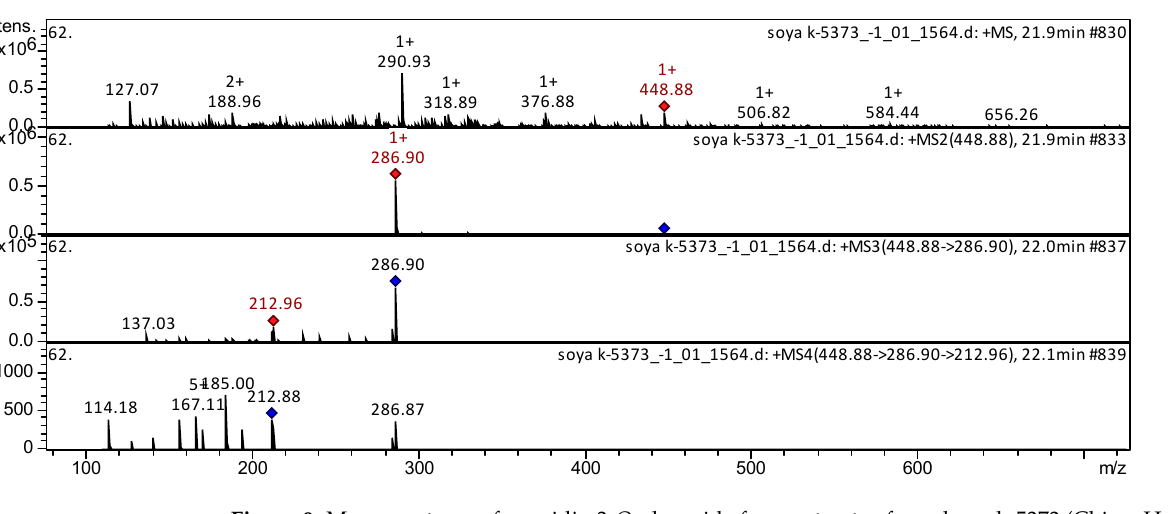
Figure 9. Mass spectrum of cyanidin 3- O -glucoside from extracts of soyabean k-5373 (China, Harbin semi-wild), m/z 448.88.